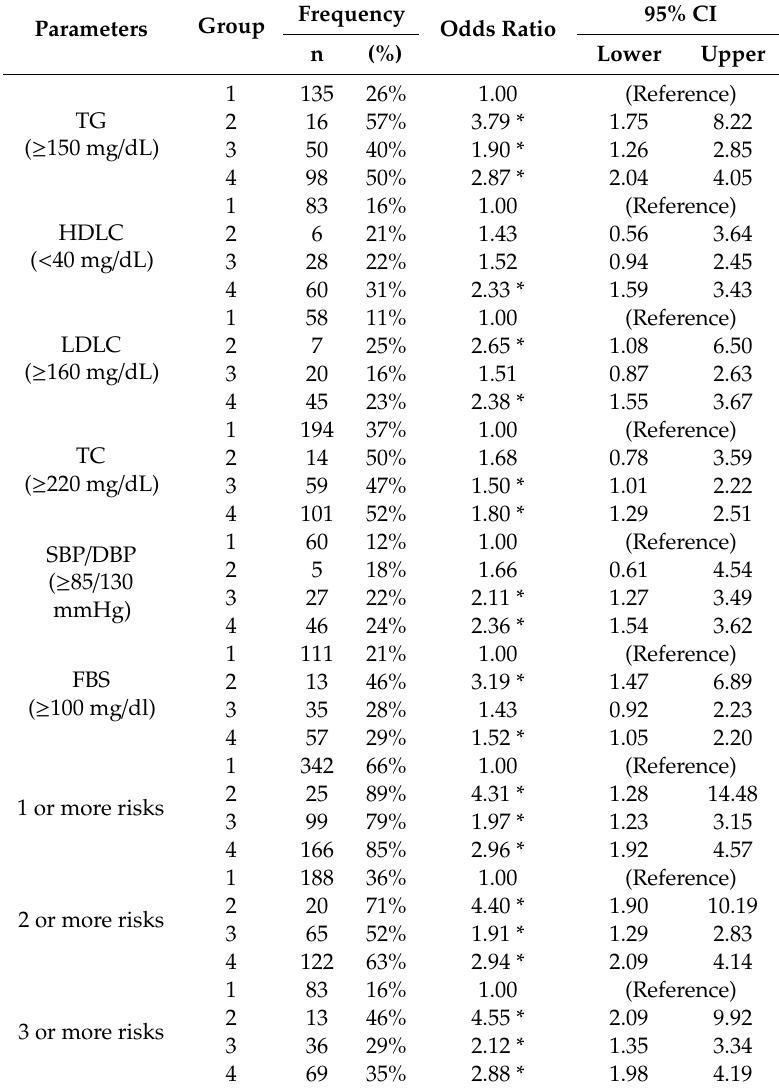
Table 3. Logistic regression analysis on cardiometabolic risk